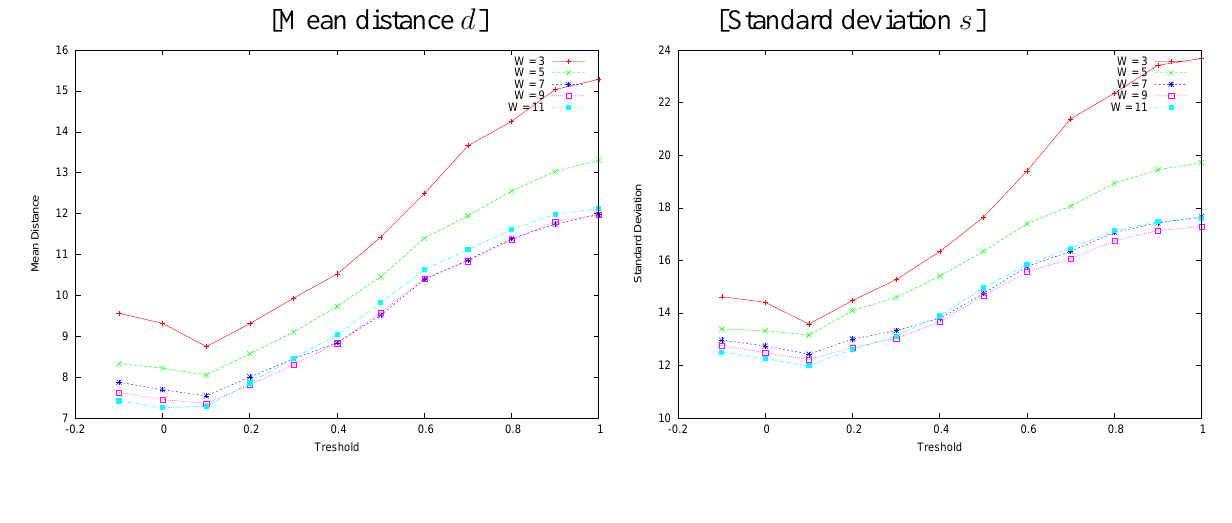
Figure 11. Measured errors for multiresolution with variable depth: Tsukuba pair. [Mean distance d ] [Standard deviation s